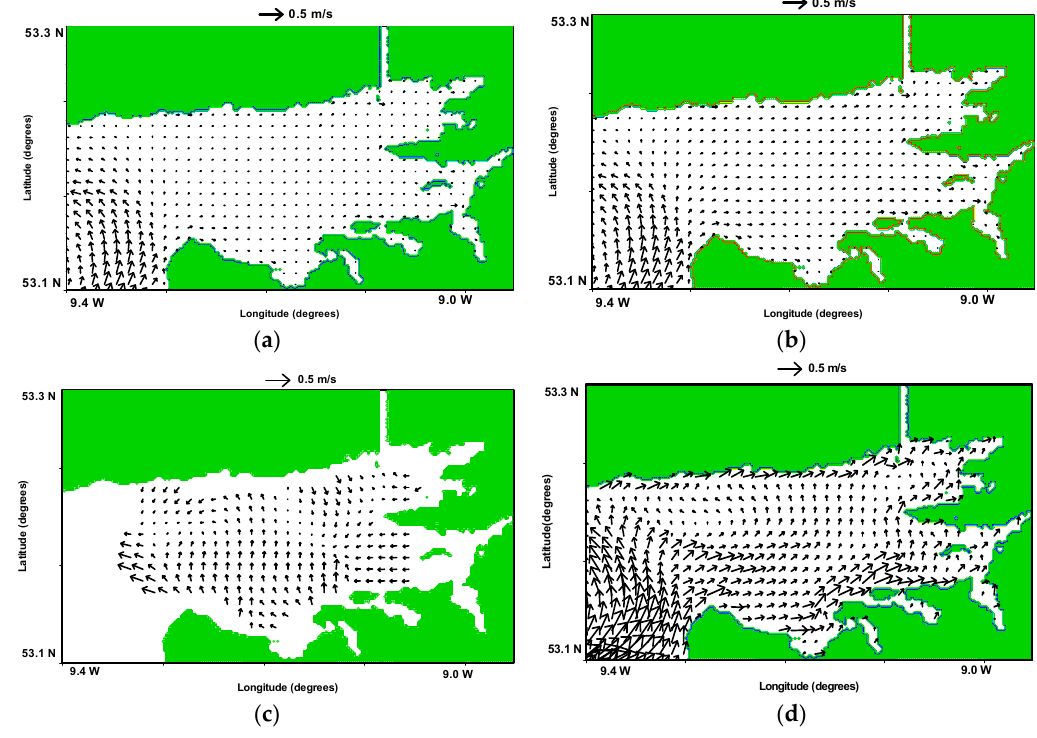
Figure 15. Low water vector fields (( a ) depth-averaged currents from model NW; ( b ) surface currents from model NW; ( c ) CODAR current data and ( d ) surface currents from model HR).